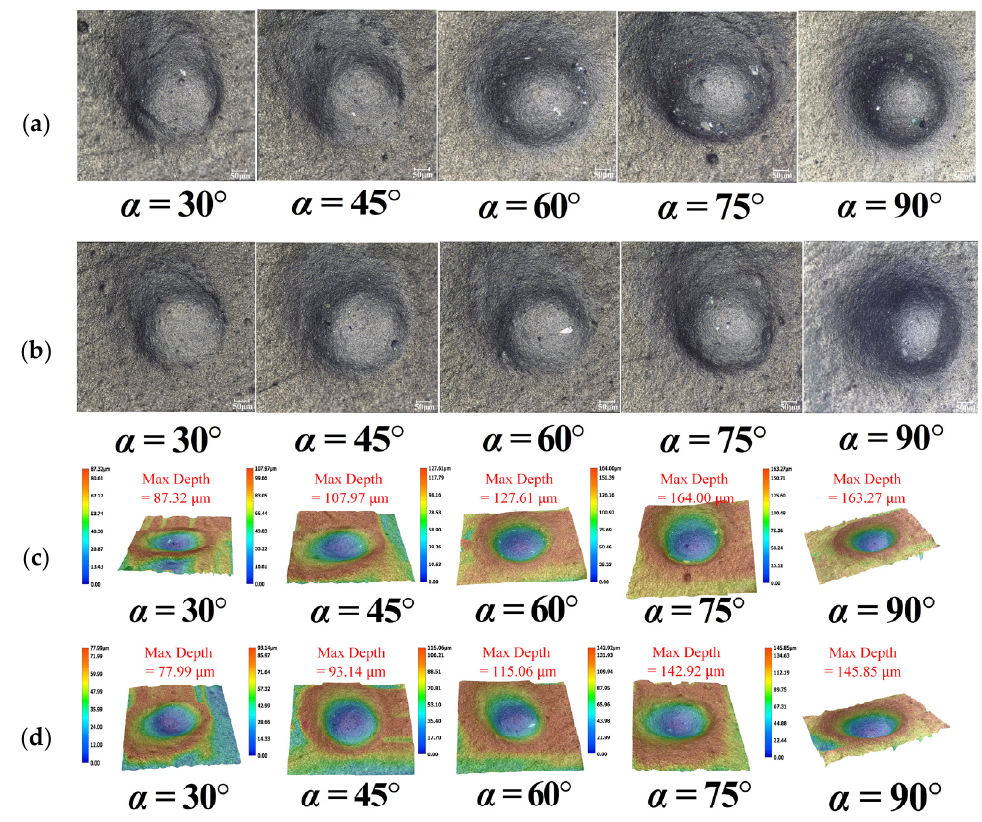
Figure 16. Erosion morphology and depth of cavities with and without self-excited oscillation under different impact angles: ( a ) Erosion morphology of SEO-AWJM, ( b ) Erosion morphology of AWJM, ( c ) Erosion depth of SEO-AWJM, ( d ) Erosion depth of AWJM.